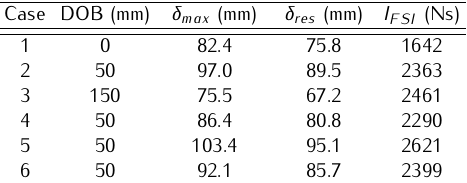
Table 9. Numerical results, where δ max is the max dynamic plate deformation, δ res the residual plate deforma- tion and I FSI the impulse